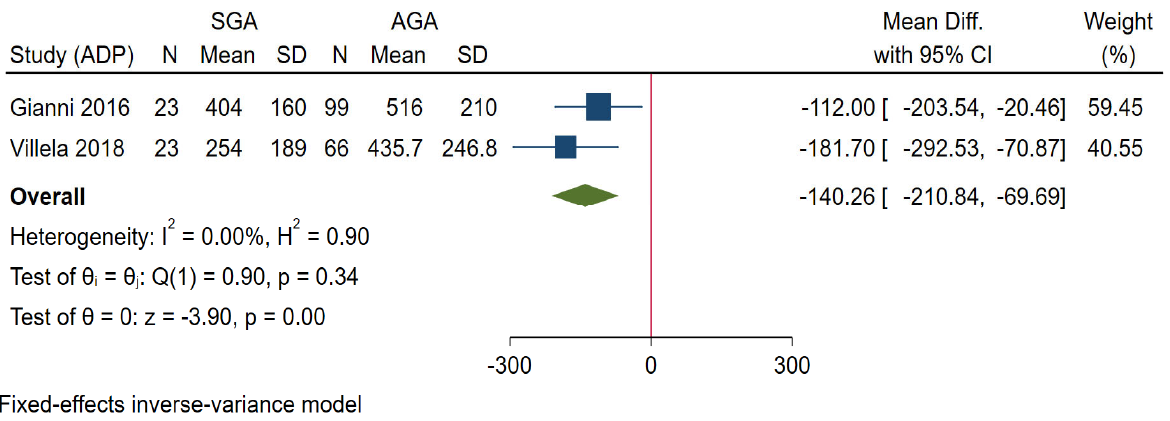
Figure 3. Forest plot showing mean difference FM at term age, between SGA and AGA infants.